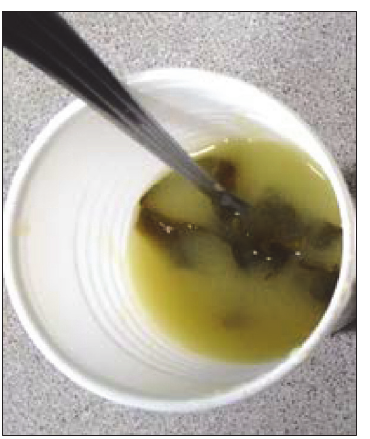
Figure 4: Sample rehydrated/incorporated in the soup distributed to the participants during the focus group session.